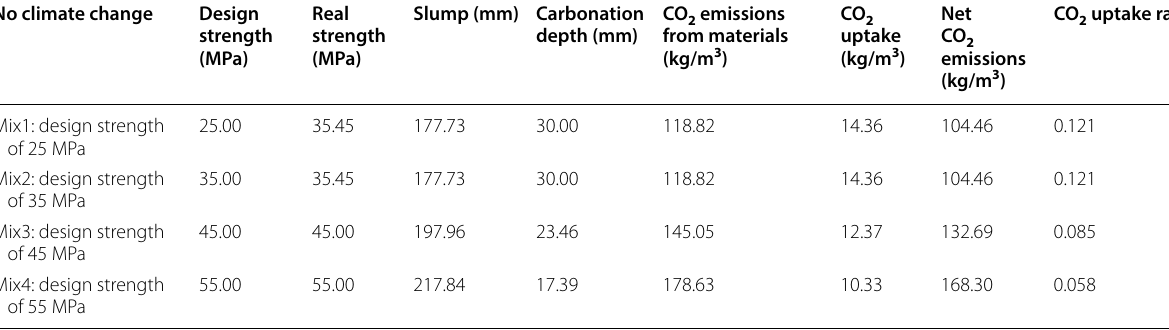
Table 6 Performance of concrete under a no climate change scenario. No climate